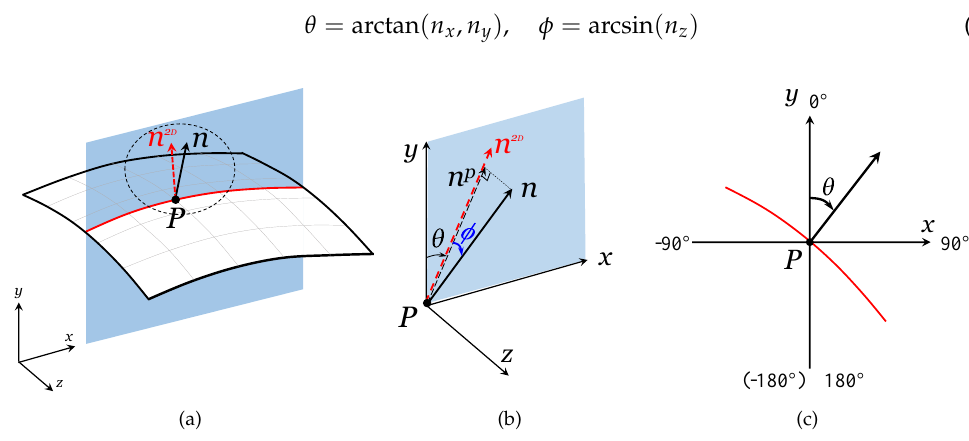
Figure 3. ( a ) The sketch of a 3D surface measured on a 2D plane; ( b ) the relation of 3D and 2D normals; ( c ) the definition of θ . xoy represents the measurement plane and z is the normal direction of xoy